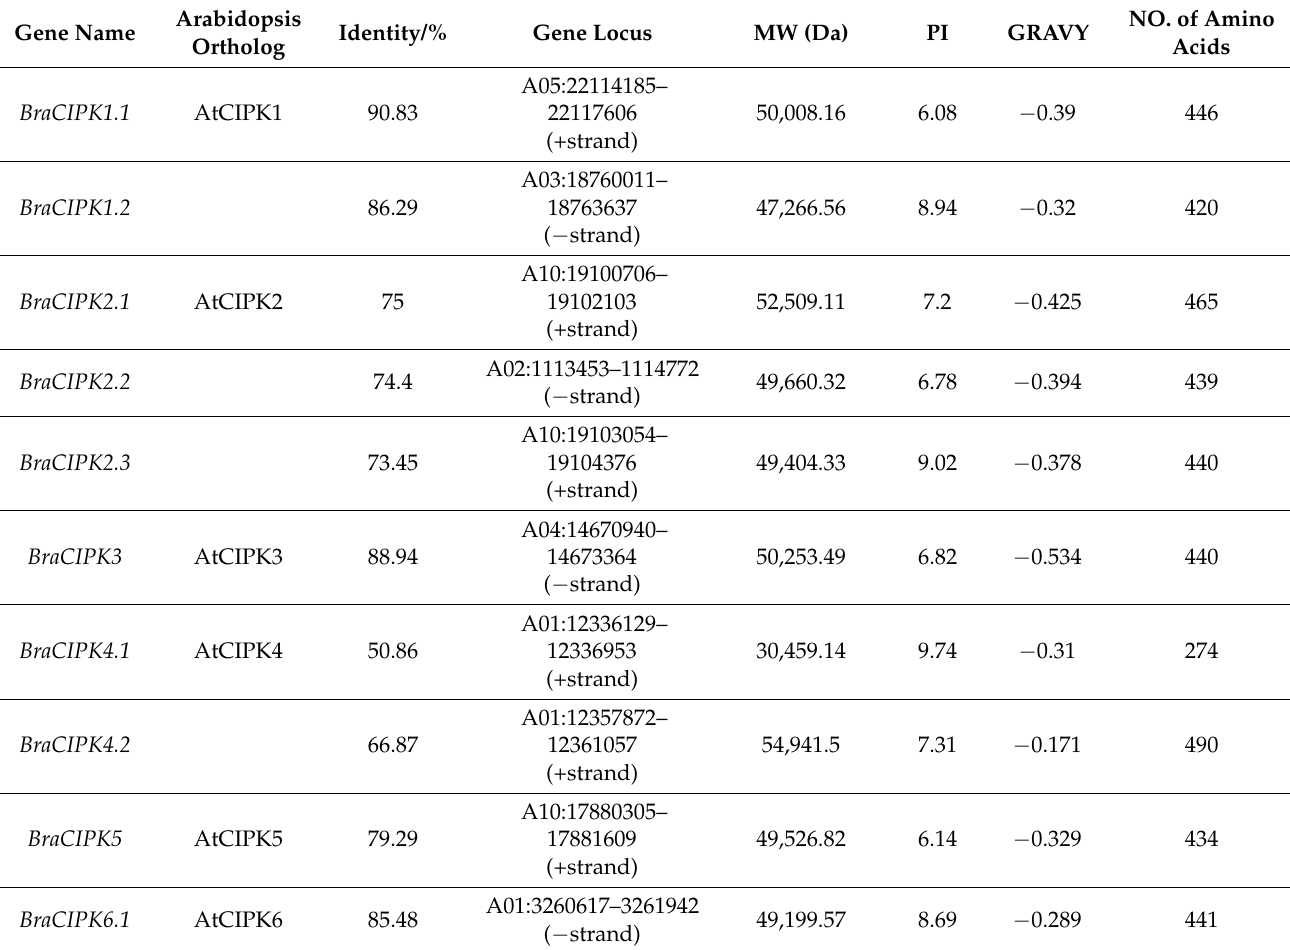
Table 2. Chinese Cabbage CIPK genes identified and their